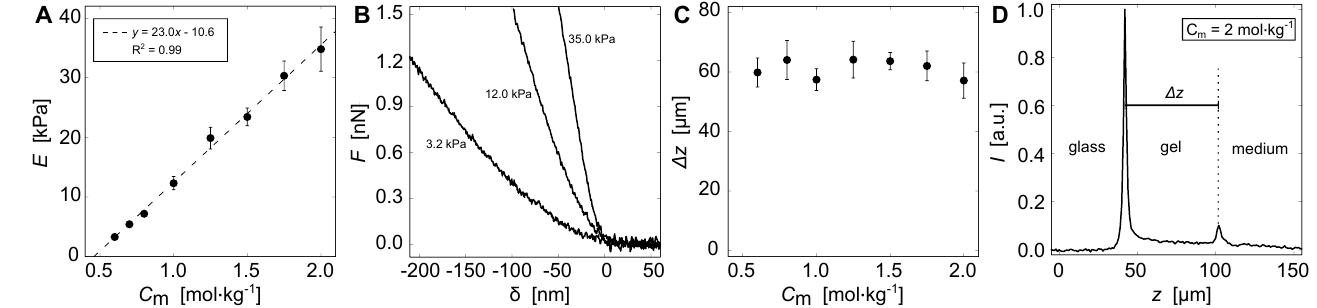
Figure 2. Property assessment of the poly-acrylamide hydrogels. ( A ) Average Young’s modulus E as